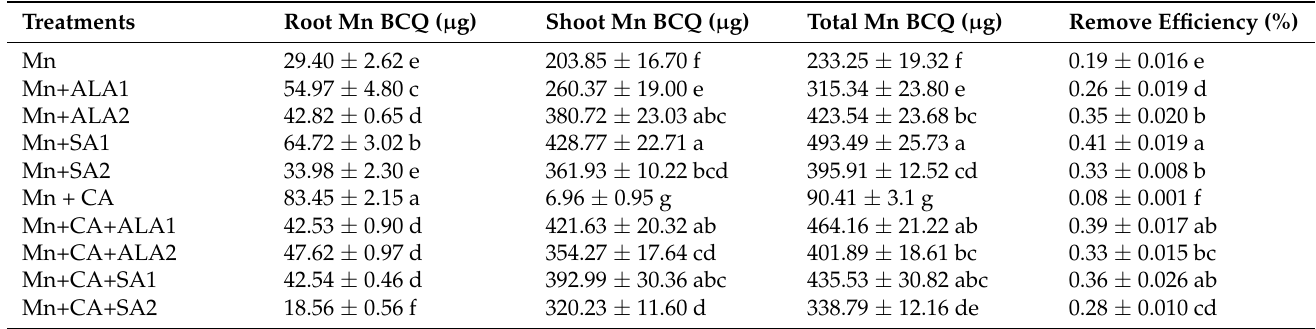
Table 4. Effects of ALA/SA combined with citric acid (CA) on manganese (Mn) bioaccumulation quantity (BCQ) and remove efficiency (RE) in sunflower under Mn